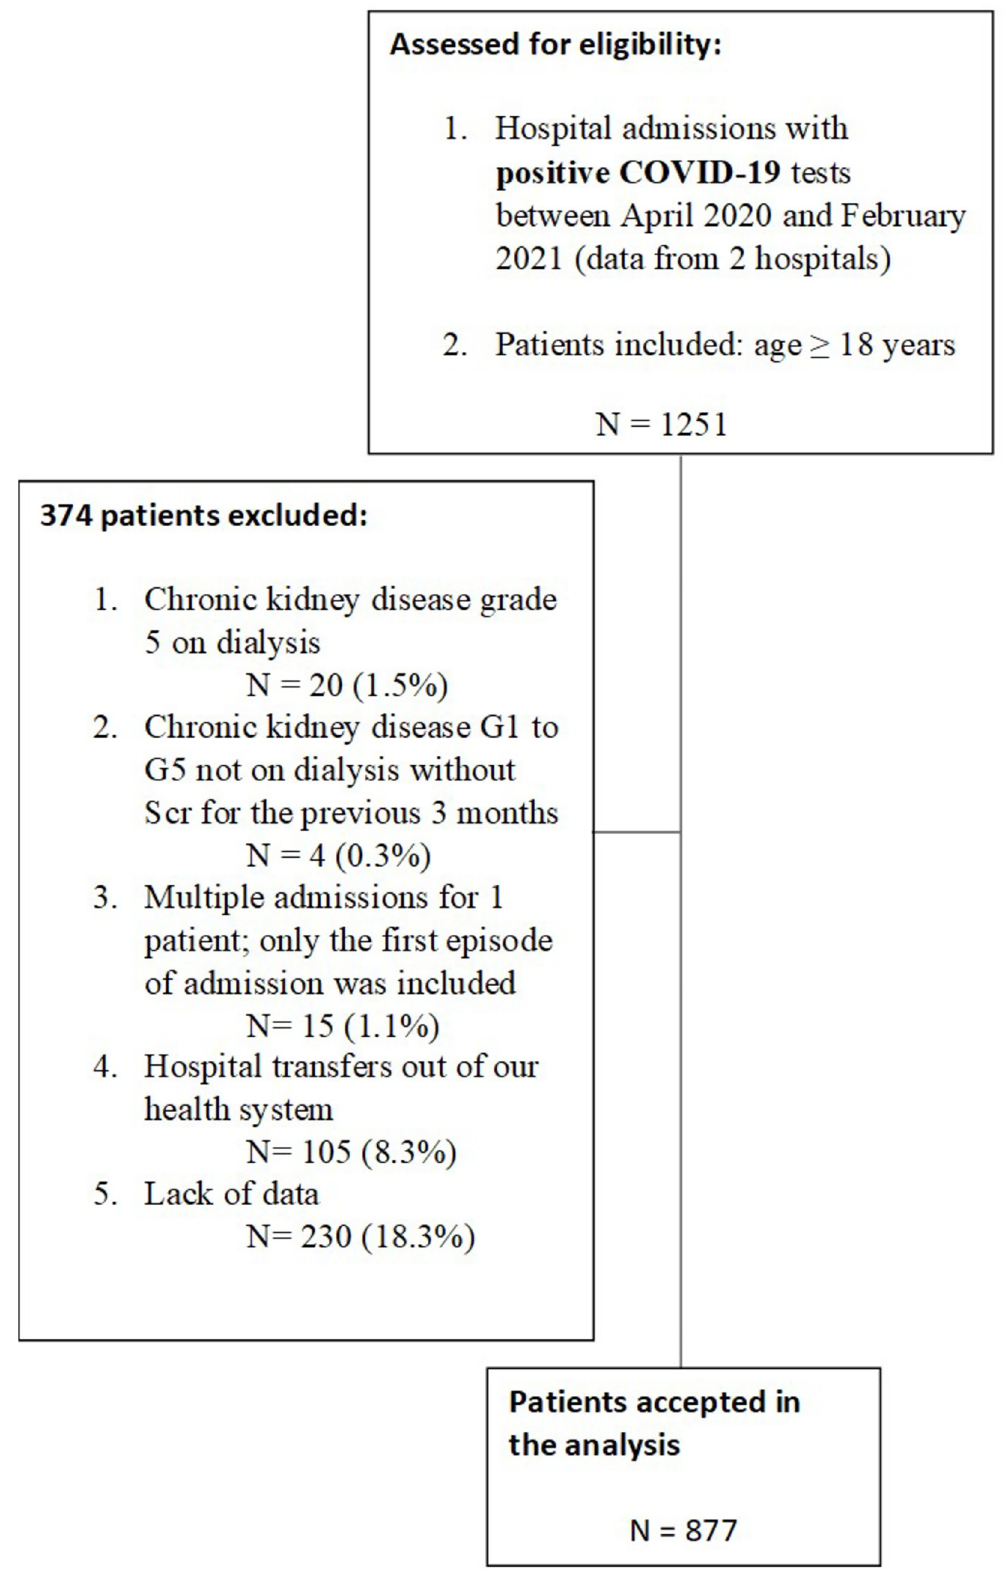
Fig 1. Flowchart of study